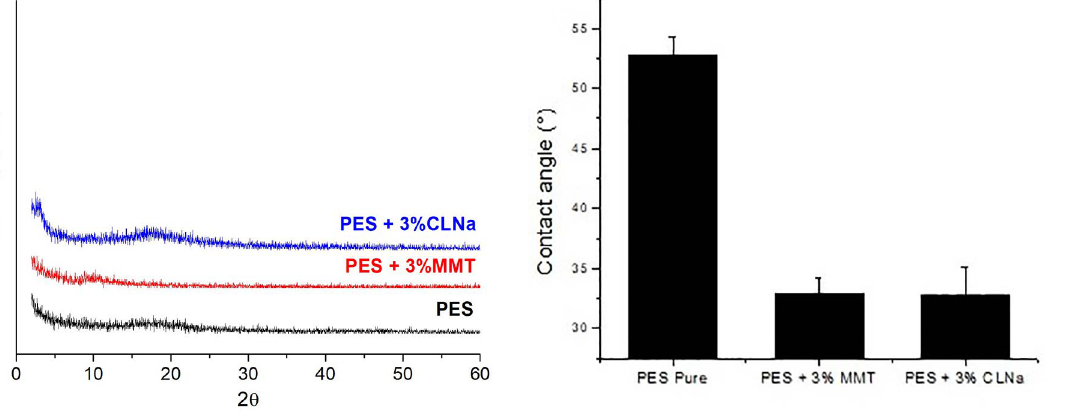
Figure 5 . Contact angle for PES and PES flat membranes with 3% MMT and